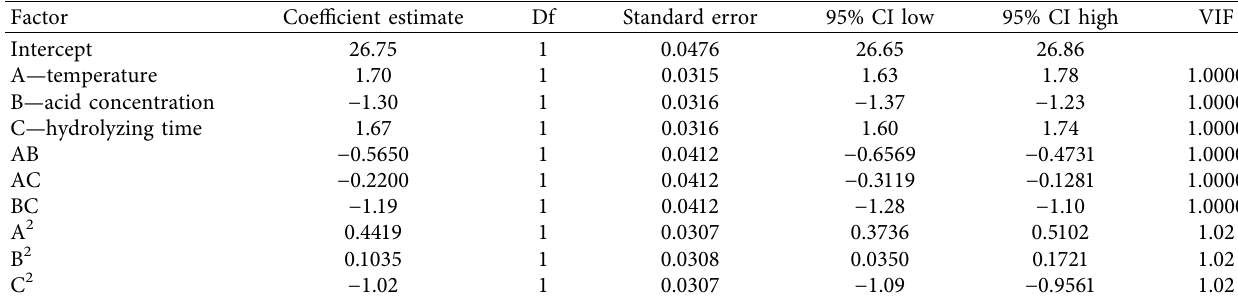
Figure 1: Injera. (a) Normal injera. (b) Leftover injera waste [19]. Table 1: Coefficients in terms of coded